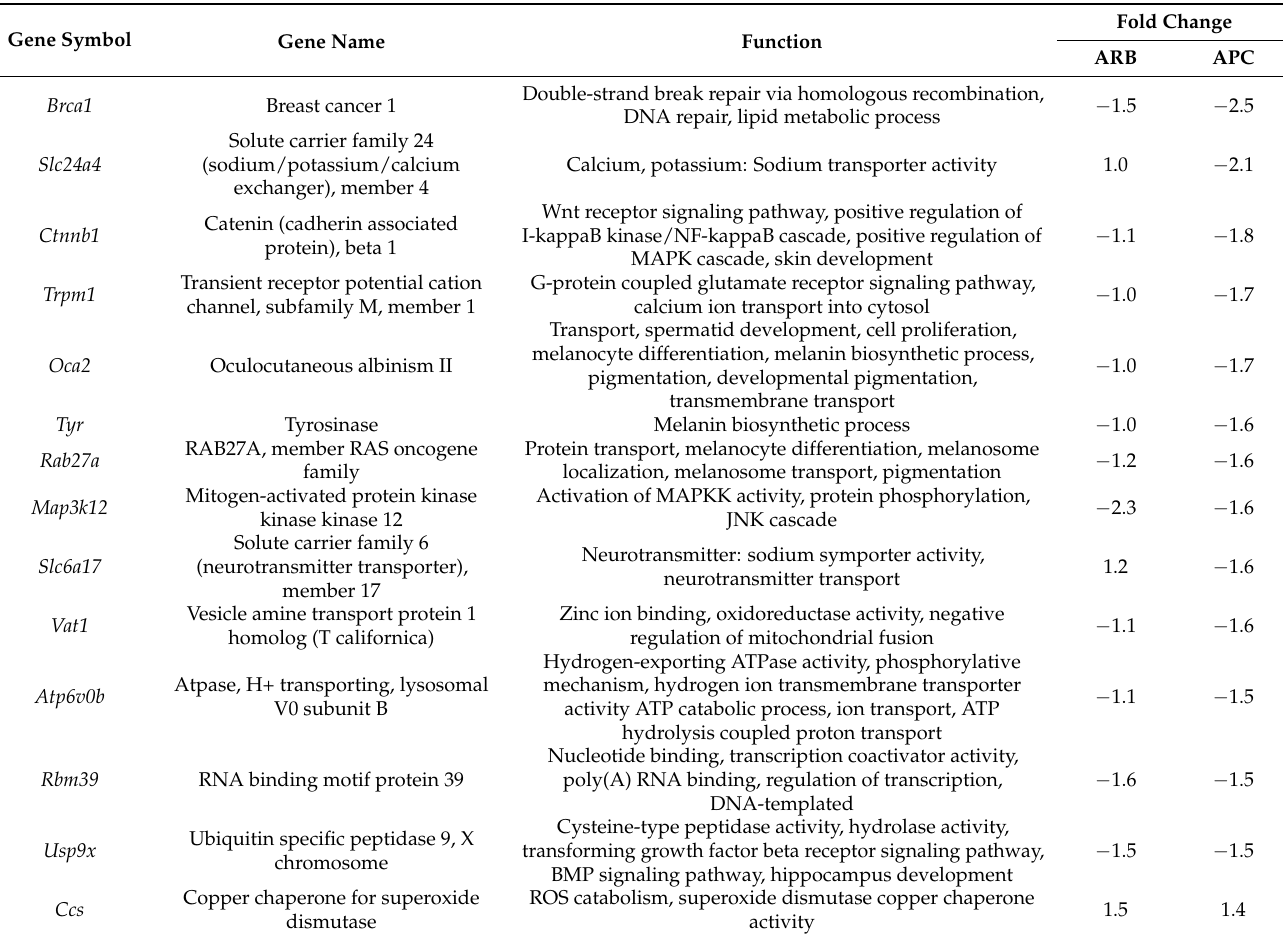
Table 1. List of genes that were differentially expressed (1.5-fold change in expression) in B16 melanoma cells treated with argan press-cake (APC) or arbutin (ARB) as determined by DNA microarray ( p < 0.05) 1 . Gene